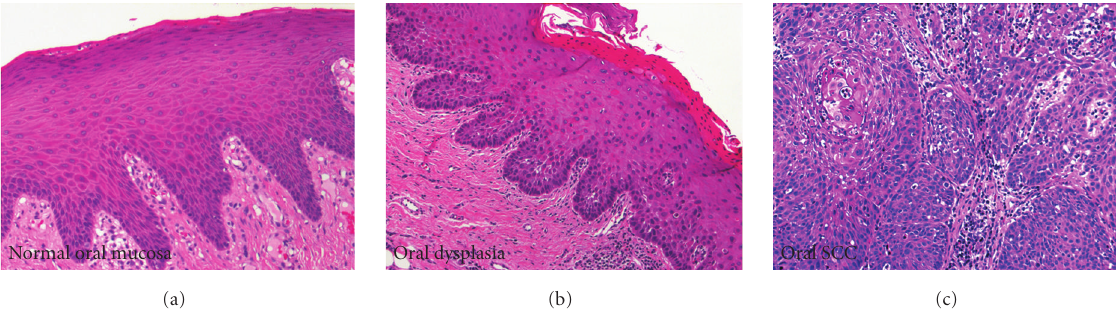
Figure 1: Morphologic evaluation of normal oral mucosa (a), dysplastic oral mucosa (b), and oral squamous cell carcinoma (c). Represent- ative sections were stained with Hematoxylin and eosin to verify the initial diagnosis of the tissue blocks used in the present